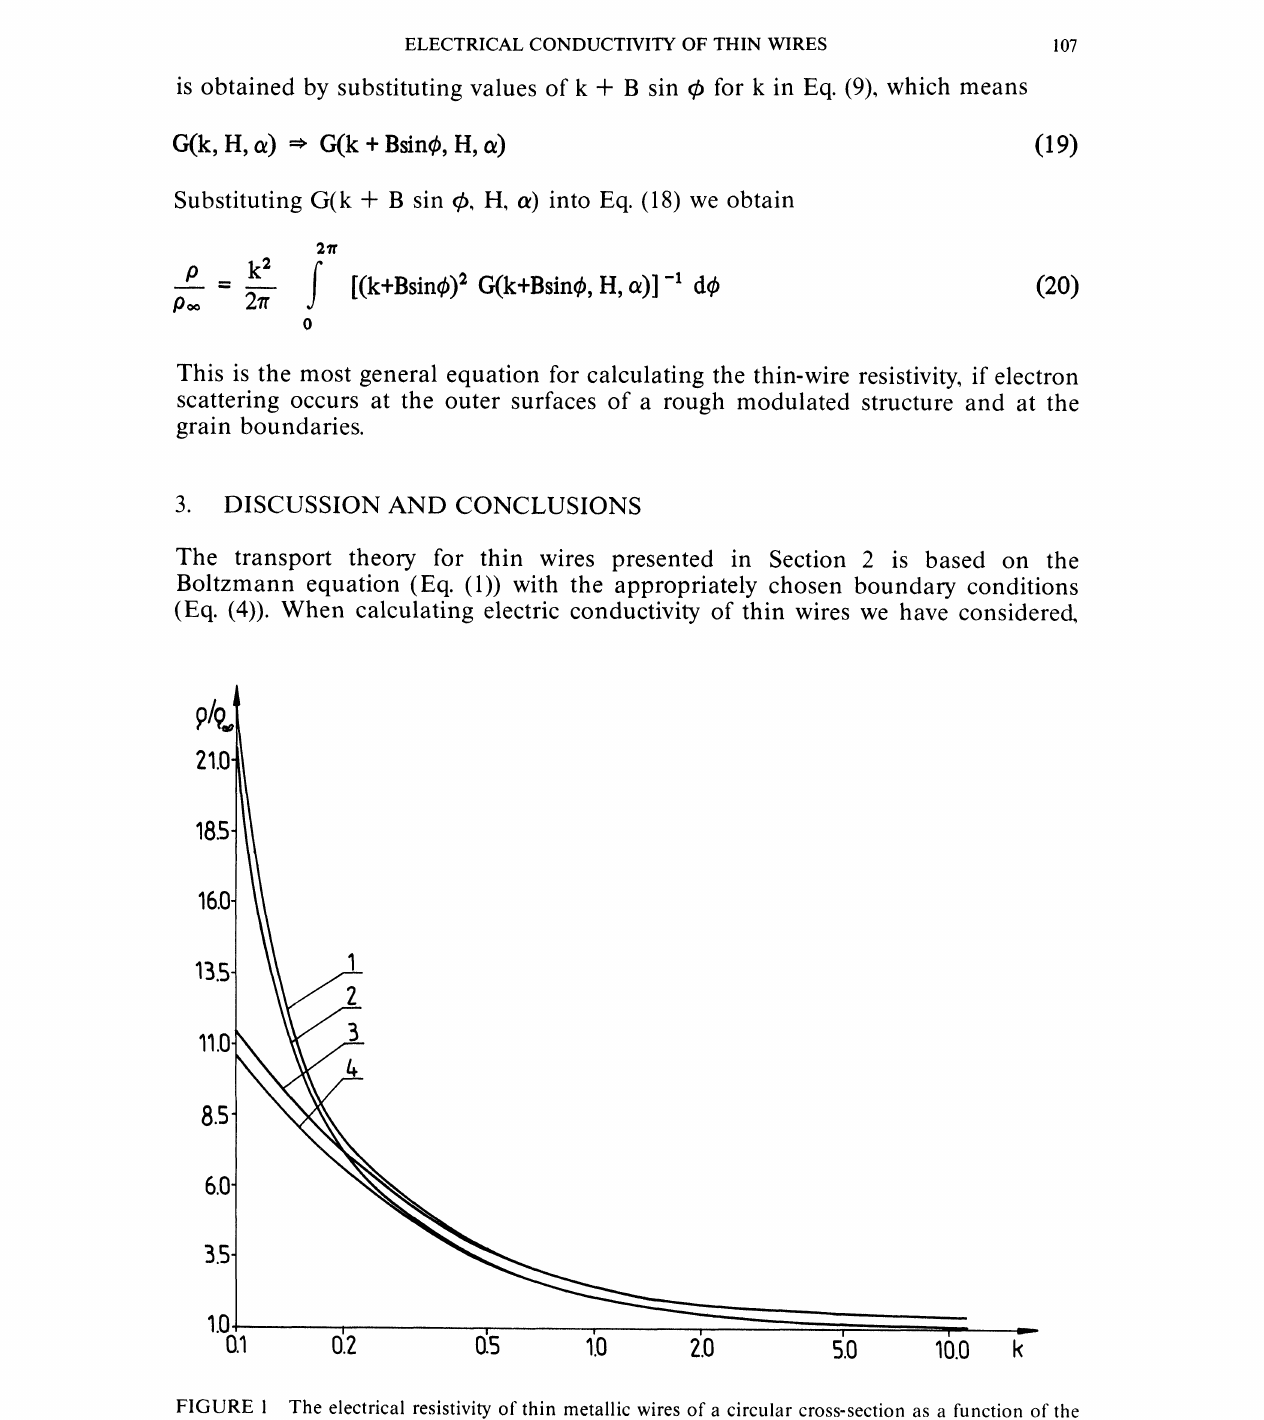
FIGURE The electrical resistivity of thin metallic wires of a circular cross-section as a function of the diameter curve for R* 0.2, T= 1.0, B 0.05 and H 1.0; curve2 for R* 0.0, B= 0.05 and H 1.0: curve for R* 0.2, T---- 1.0. B 0.0 andH-- 1.0; curve 4 for R* 0.0.B 0.0 and H